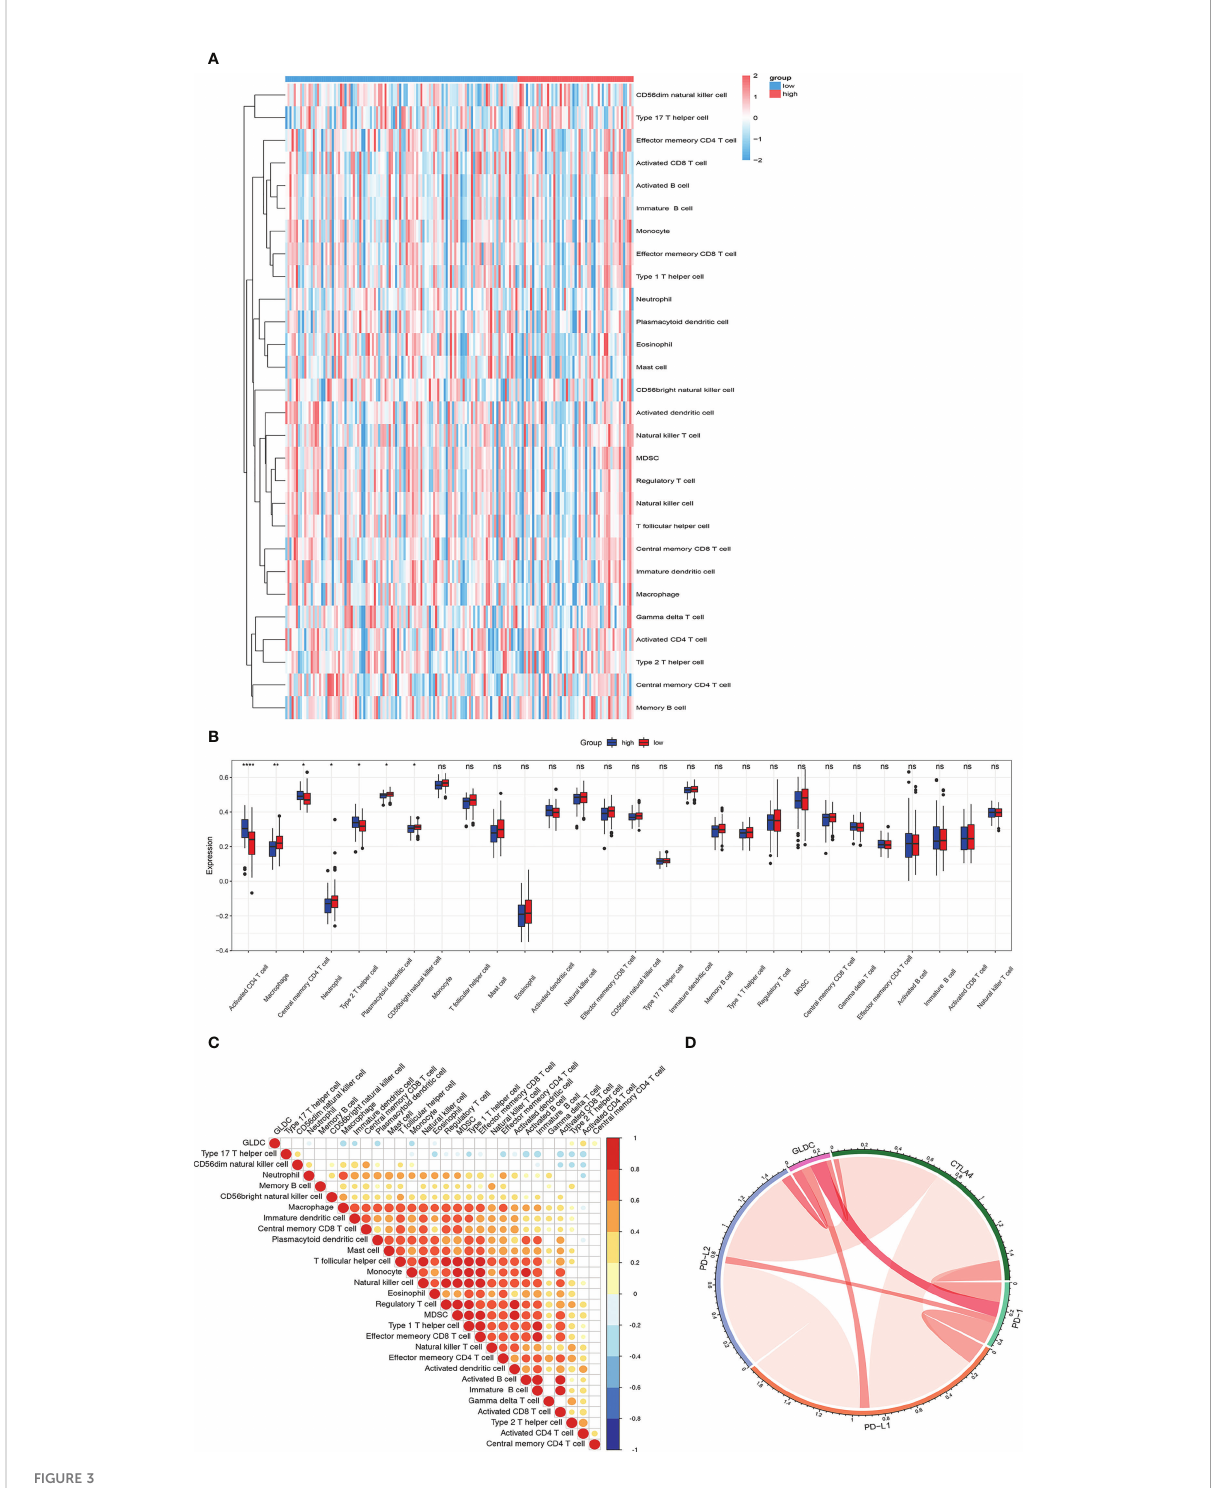
FIGURE 3 The relationship between GLDC and tumor immune in fi ltration. (A) The in fi ltration abundance of immune cells based on the levels of GLDC in TNBC patients. (B) High levels of macrophage, neutrophil, CD56 bright natural killer cell and plasmacytoid dendritic cell and low levels of activated CD4 T cell, central memory CD4 T cell, and type 2 T helper cell were acquired in the group with low expression of GLDC in TNBC. (C) The expression of GLDC was negatively correlated with macrophage, plasmacytoid dendritic cell, and monocyte and positively correlated with activated CD4 T cell and type 2 T helper cell. (D) No signi fi cant correlations were observed between GLDC and the four immune checkpoint molecules in TNBC. *P < 0.05, **P < 0.01, ***P < 0.001, and ns indicates